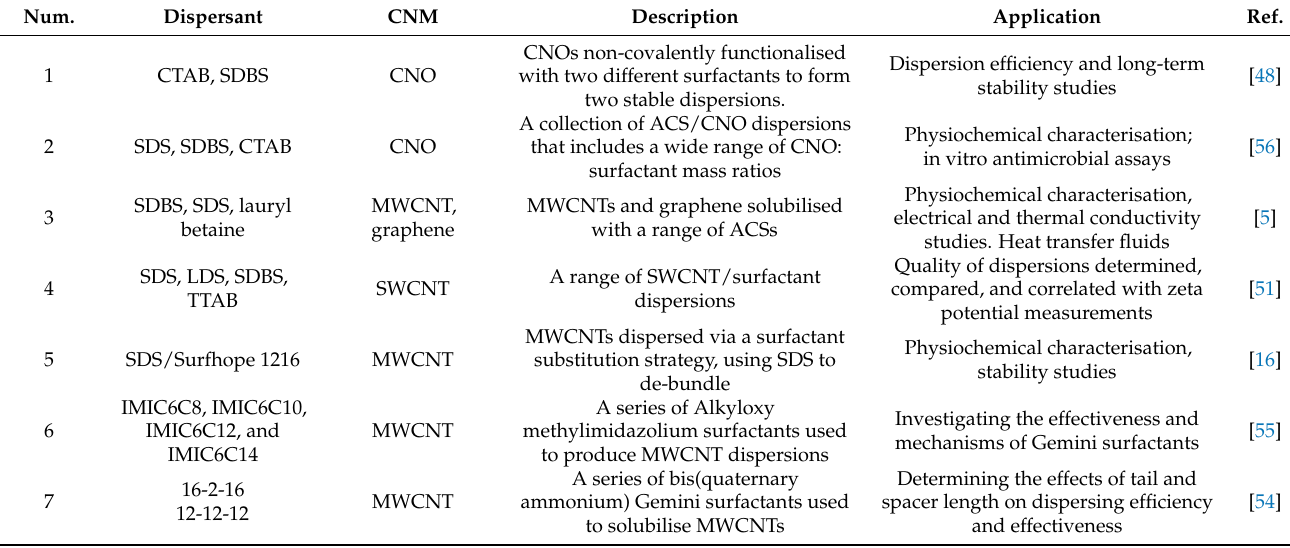
Table 4. Alkyl chain surfactant-based CNM